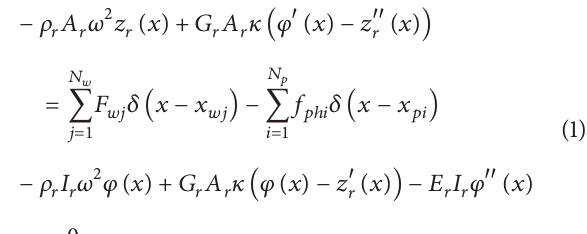
Table 1: Degrees of freedom of the system model. System component Wheelset